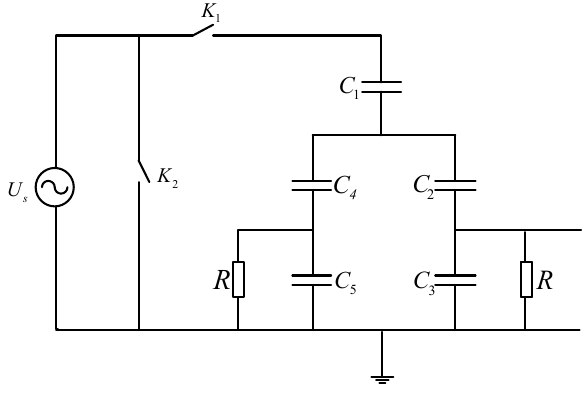
Figure 6. The simulation circuit of ECVT.